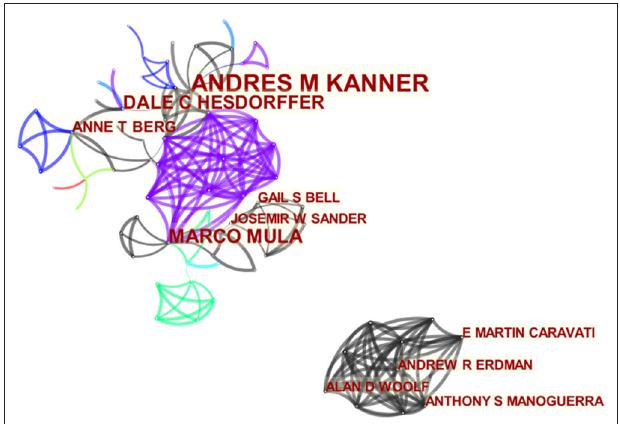
FIGURE 4 | The network of co-authors.